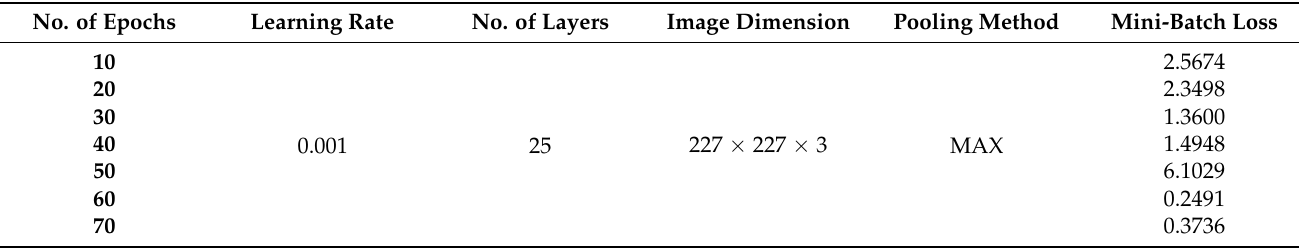
Table 4. Proposed model training simulation